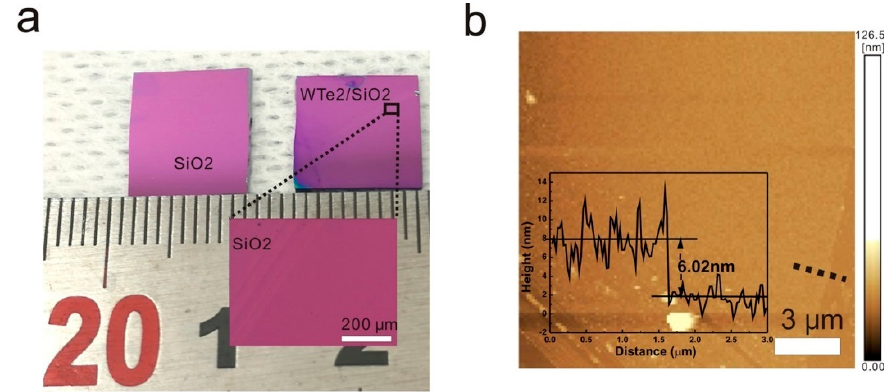
Figure 6. ( a ) The dimensions of the synthesized 1T ′ -WTe 2 by chemical vapor deposition (CVD) (SiO 2 /Si substrate); ( b ) atomic force microscopy (AFM) image of the 1T ′ -WTe 2 [37]. substrate); ( b ) atomic force microscopy (AFM) image of the 1T (cid:48) -WTe